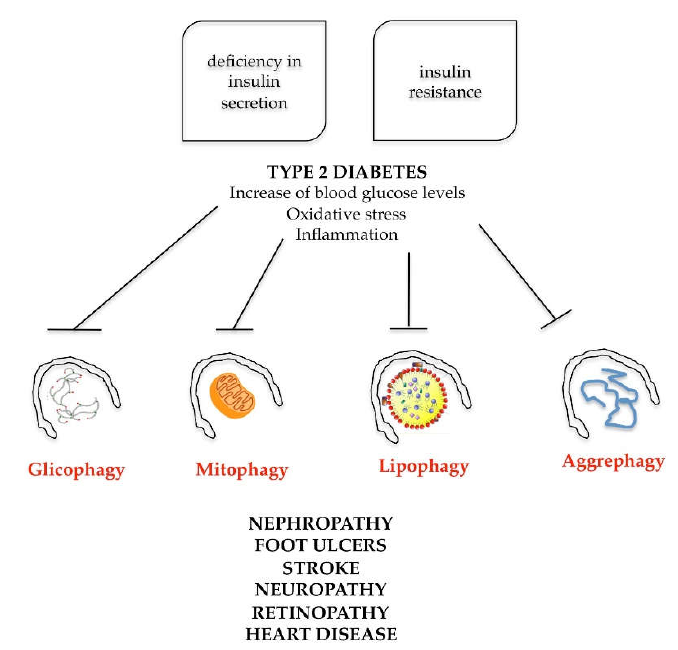
Figure 7. Schematic representation of autophagy involvement in metabolic syndrome. Type 2 diabetes, due to deficiency in insulin secretion or insulin resistance, increases blood glucose levels, oxidative stress and inflammation. These cellular events are able to inhibit different types of selective autophagy, such as glicophagy, mitophagy, lipophagy or aggrephagy with consequent systemic effects.